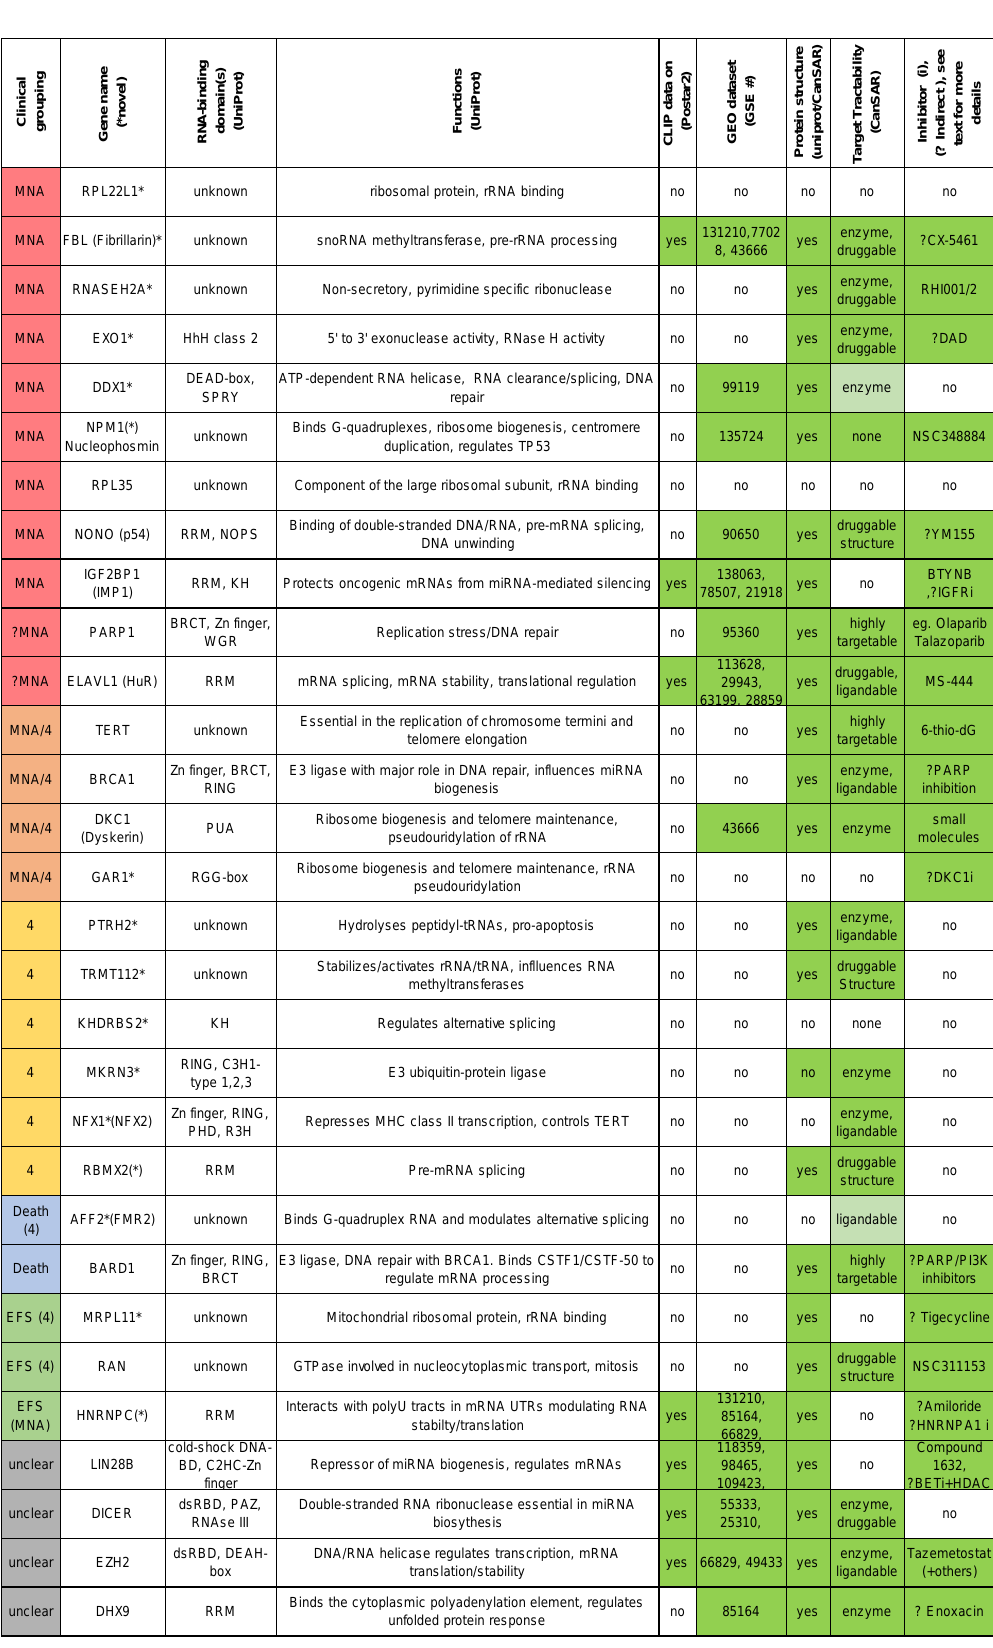
Figure 5. Selected novel and reported oncogene-like RBP characteristics with crystal structures and inhibitors listed. Green in columns on the right indicate favourable characteristics for drug